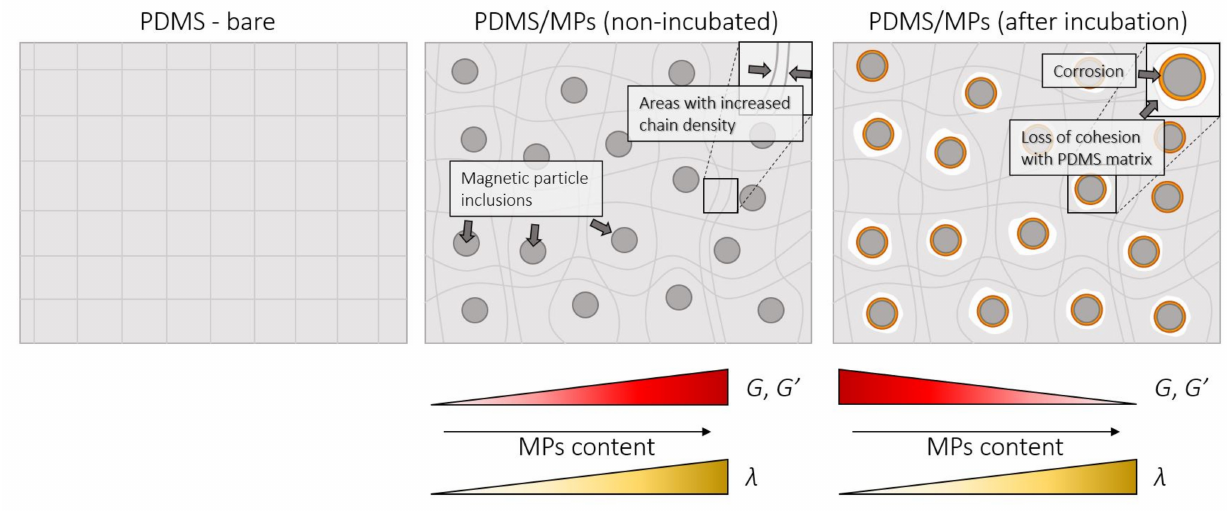
Figure 11. Mechanism of changes in rheological properties in PDMS-MPs